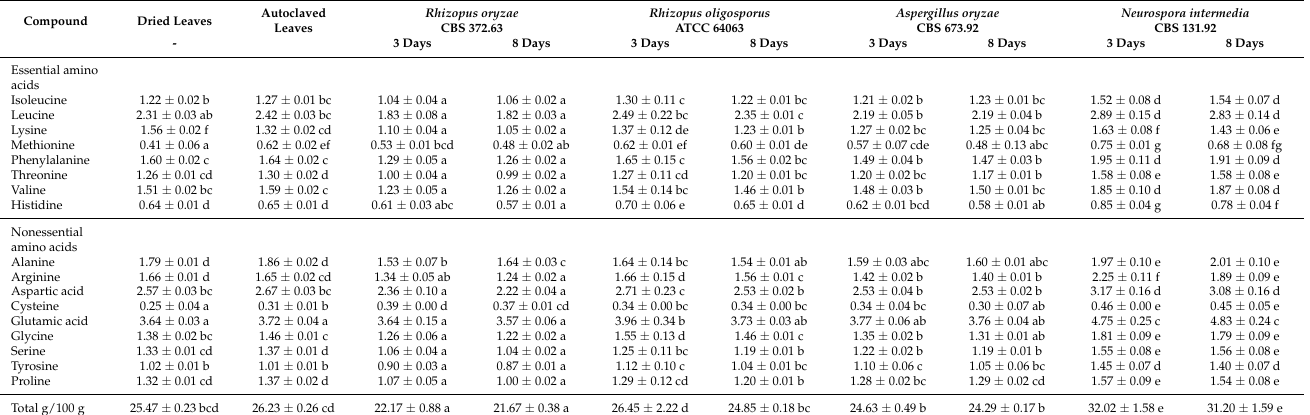
Table 3. The quantification of amino acids (g/100 g DM) in moringa leaves—dried, autoclaved, and